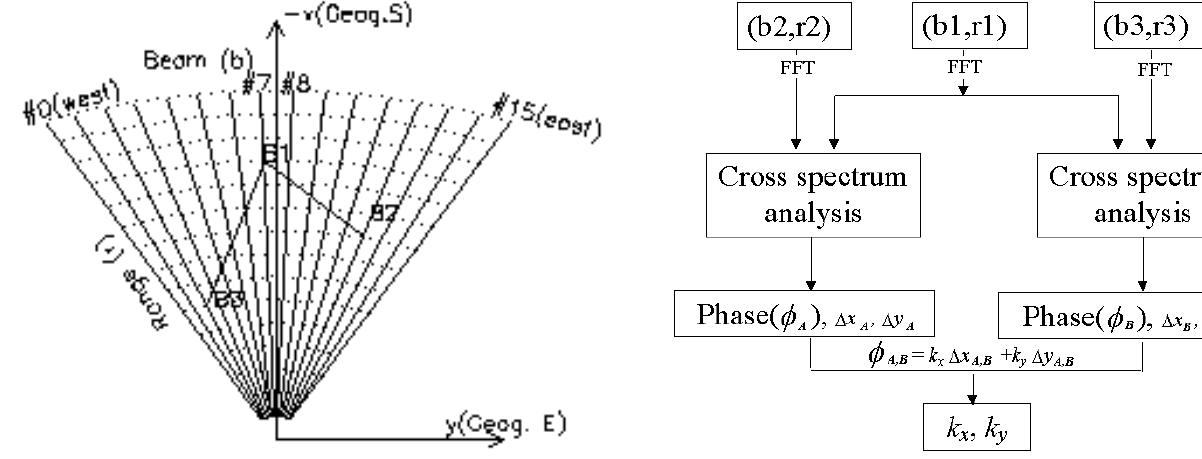
Fig. 2 Fig. 2. Flow chart of FFT cross-spectral analysis method used to determine MSTID wave numbers from TIGER SuperDARN radar observations. A specific observation cell in the TIGER’s field of view is identified by beam number b i and range cell r j , where i =0, 1, 2, ..., 15; j =1, 2, ..., 75. The time series of echo power at three observation cells is then used to determine k x and k y